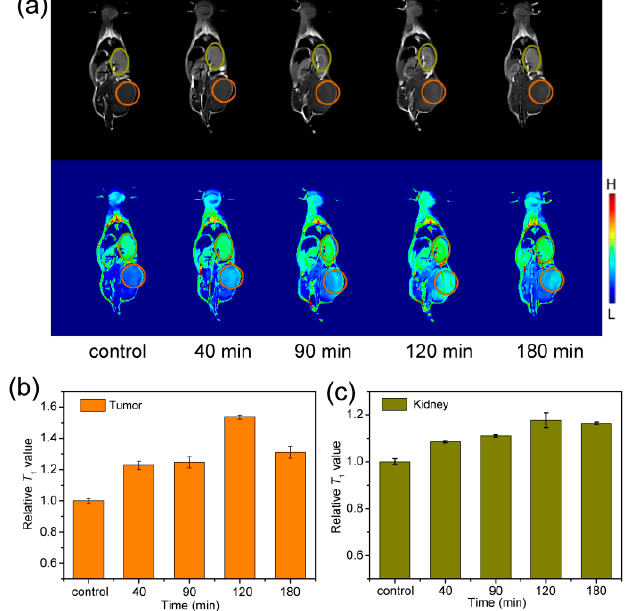
Figure 6. ( a ) T 1 -weighted MR images (B 0 = 1 T) of mice collected before (control group) and after intravenous injection of Fe 3 O 4 -PVA at time points of 40, 90, 120 and 180 min. The corresponding relative T 1 -weighted signals extracted from ( b ) tumor (orange circle) and ( c ) kidney (dark yellow circle) sites.